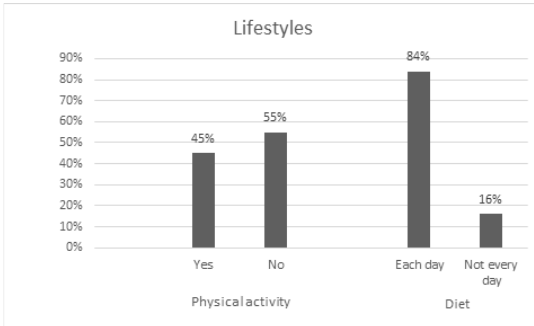
Figure 2. Distribution of the lifestyles in physicians.